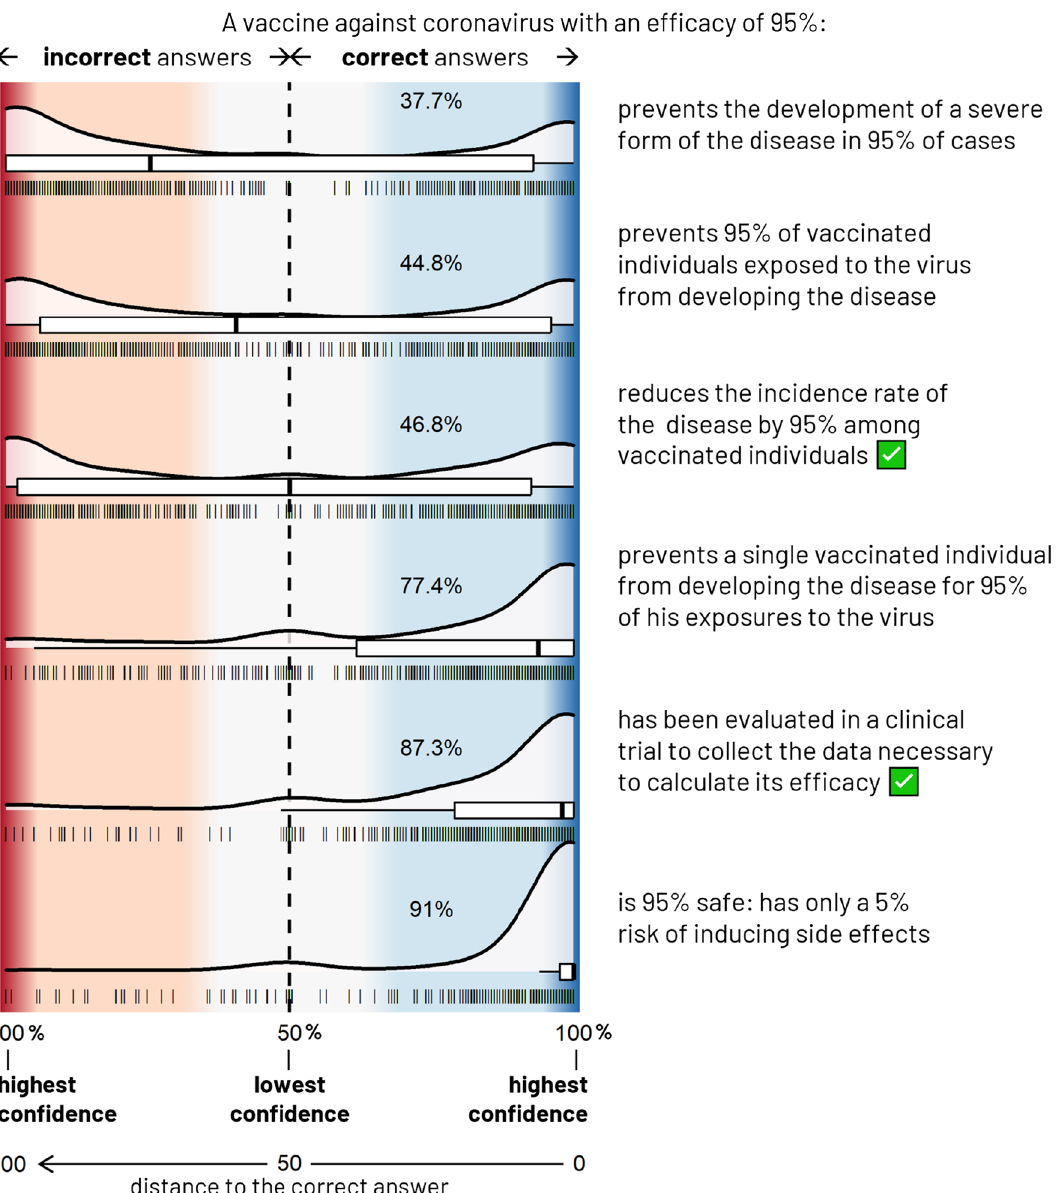
Fig. 2 Responses to the “vaccine efficacy” exercise, N 822. The density and box plots represent the distribution of participants’ responses for = each of the 6 proposed claims. The collected data are here mapped onto a double‑sided probability scale ranging from 50% (lowest confidence, the participant answered randomly) to 100% (maximal confidence judgment), both for correct (blue area) and incorrect (red area) answers. Also represented on the x‑axis, the distance to the correct answer (d) is defined as a score composed both by the accuracy and confidence, ranging from 0: correct answer with maximal confidence to 100: incorrect answer with maximal confidence through 50: “I do not know”, d < 50 and d > 50, respectively, corresponding to correct and incorrect answers. Each vertical line stands for a response. The percentage of this exercise’s participants who gave a correct answer is indicated in each blue area. True claims are indicated by a green ticked